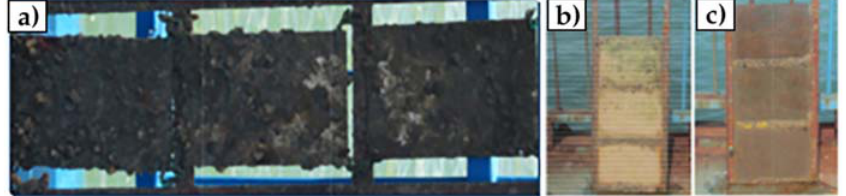
Figure 7. In situ marine fouling tests over a period in a sheltered bay connected to the south China sea. Bared panels (90 days) ( a ); Cu 2 O paint ‐ coated surfaces (365 days) ( b ); and GO/Cu 2 O paint ‐ coated surfaces (365 days) ( c ). Reprinted with adaptations from [70], under the terms of the Creative Commons Attribution International License (CC BY 4.0).